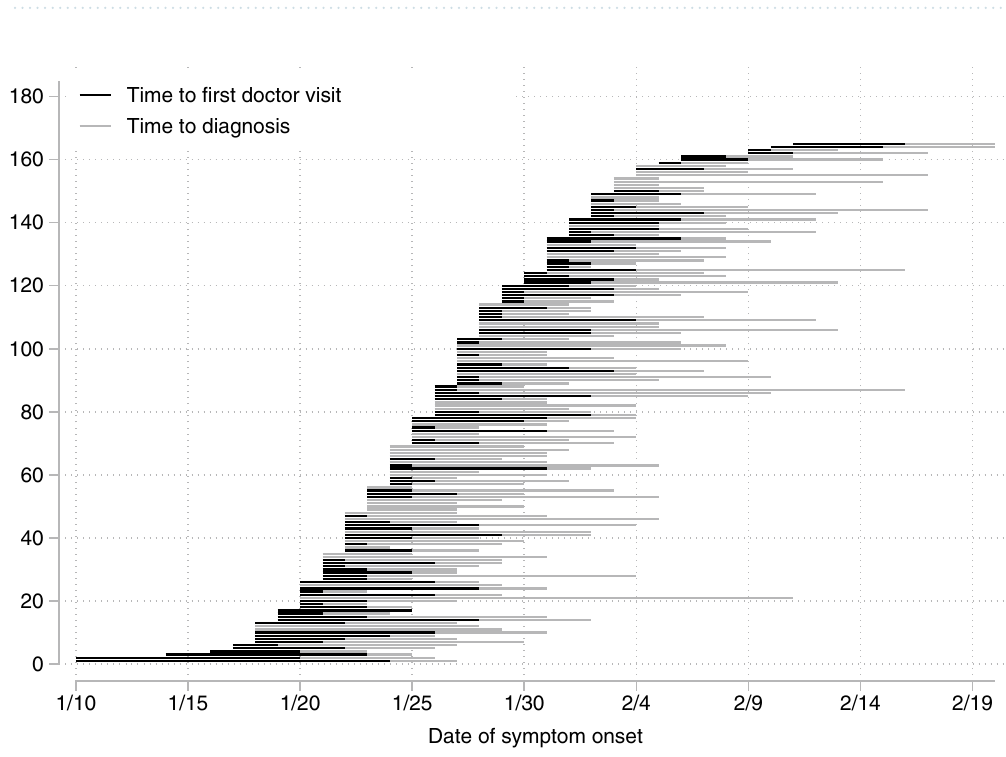
Table 1. Descriptive statistics of the study sample ( N = 165 ). N = 165 . Large cities is a dichotomous variable that takes the value 1 if an individual lives in a city and 0 if living in counties or rural area. The prefecture of Tongchuan has no confirmed cases in this working sample.